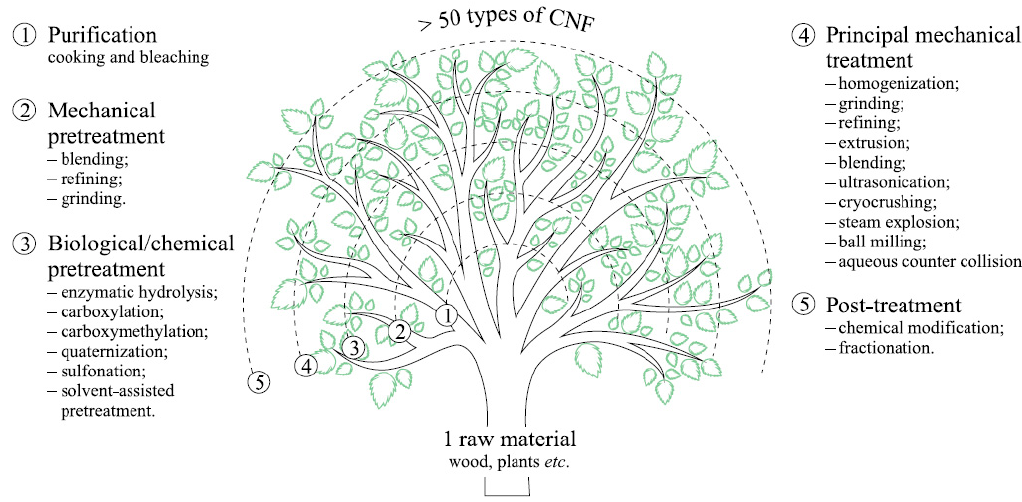
Figure 5. Production process of Nanofibrillated Cellulose (NFC): combination of different operations. Reproduced from reference [89] with the permission of Elsevier.